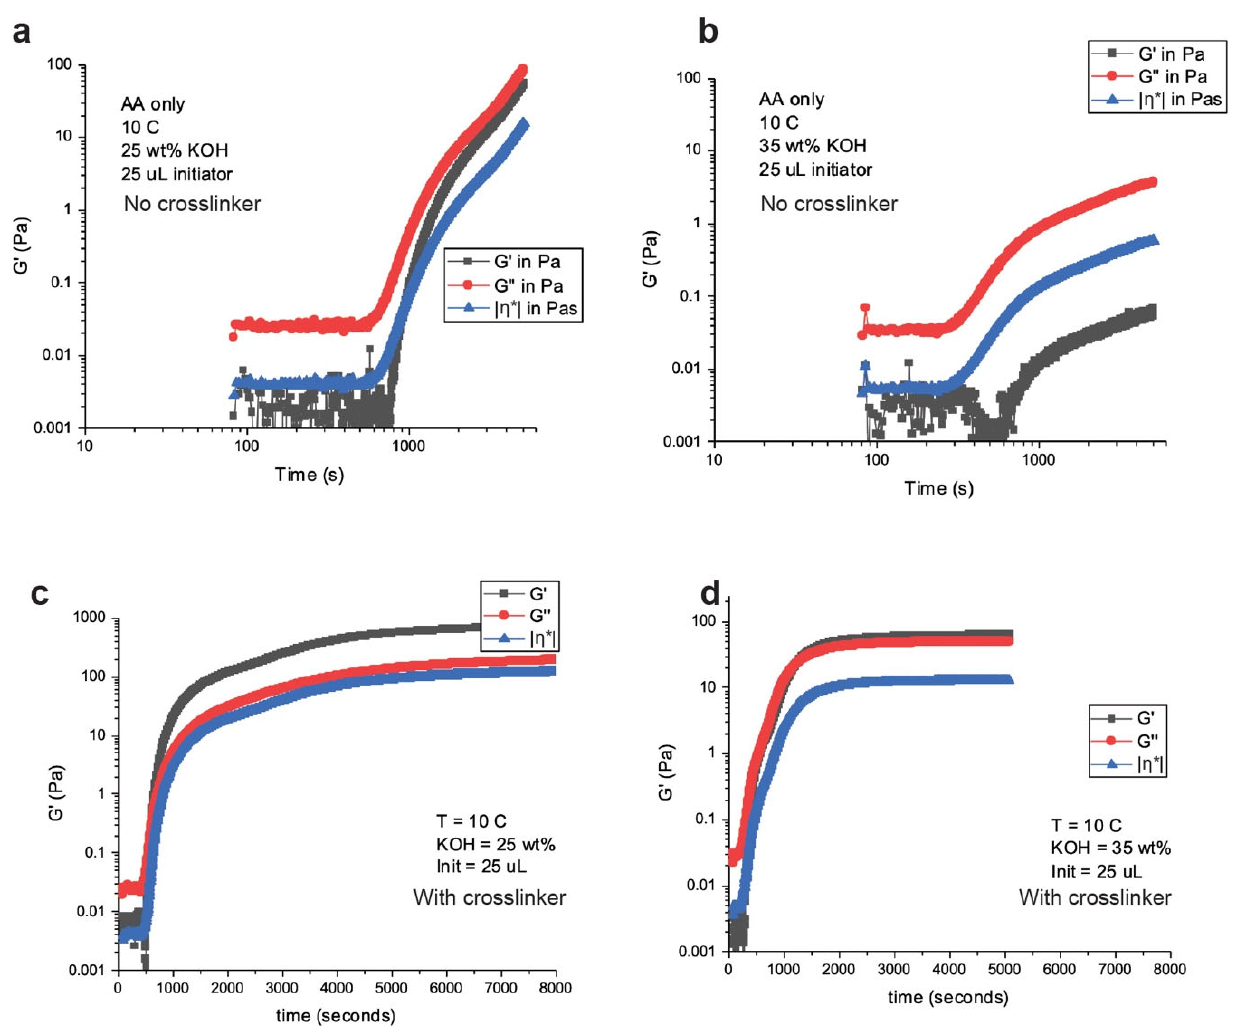
Figure 4. Measurement of storage and loss modules over time of ( a ) non-crosslinked 25 wt.% KOH, ( b ) non-crosslinked 35 wt.% KOH, ( c ) crosslinked 25 wt.% KOH and ( d ) crosslinked 35 wt.% KOH.